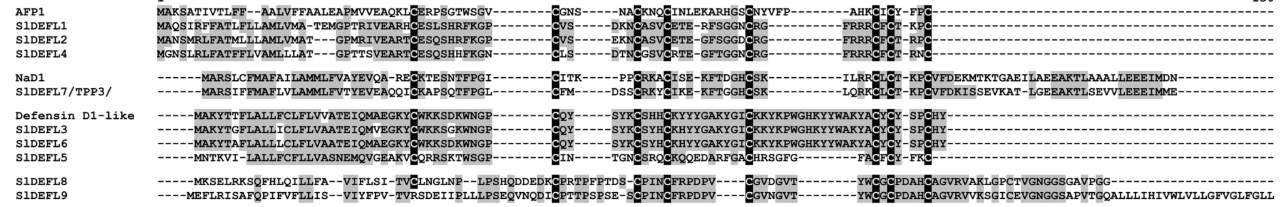
Figure 1. Multiple sequence alignment of S. lycopersicum DEFL precursors and Arabidopsis thaliana AFP1 (NP_565119.1), Nicotiana alata NaD1 (AAN70999.1), and Solanum pennellii defensin D1-like (XP_015081705.1). Cysteine residues are shaded black, and identical amino acids are shaded